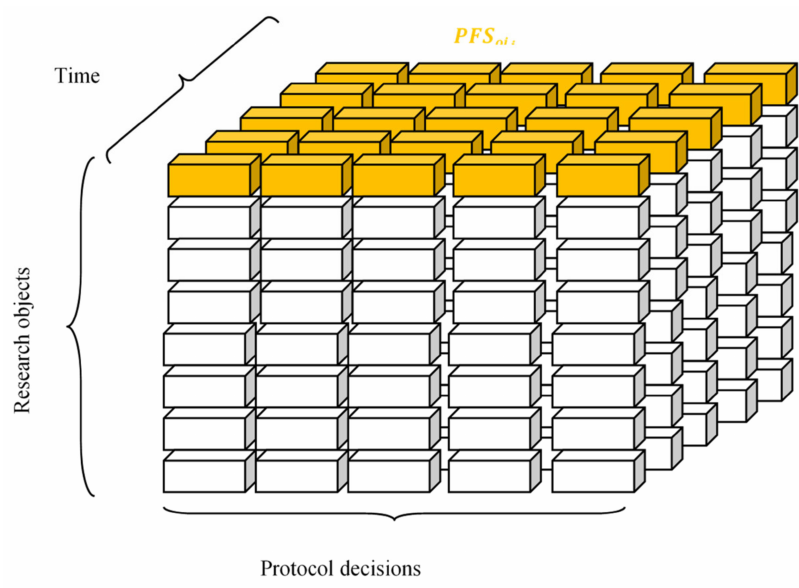
Figure 4. Model of the condition space of the object, taking into account the medical